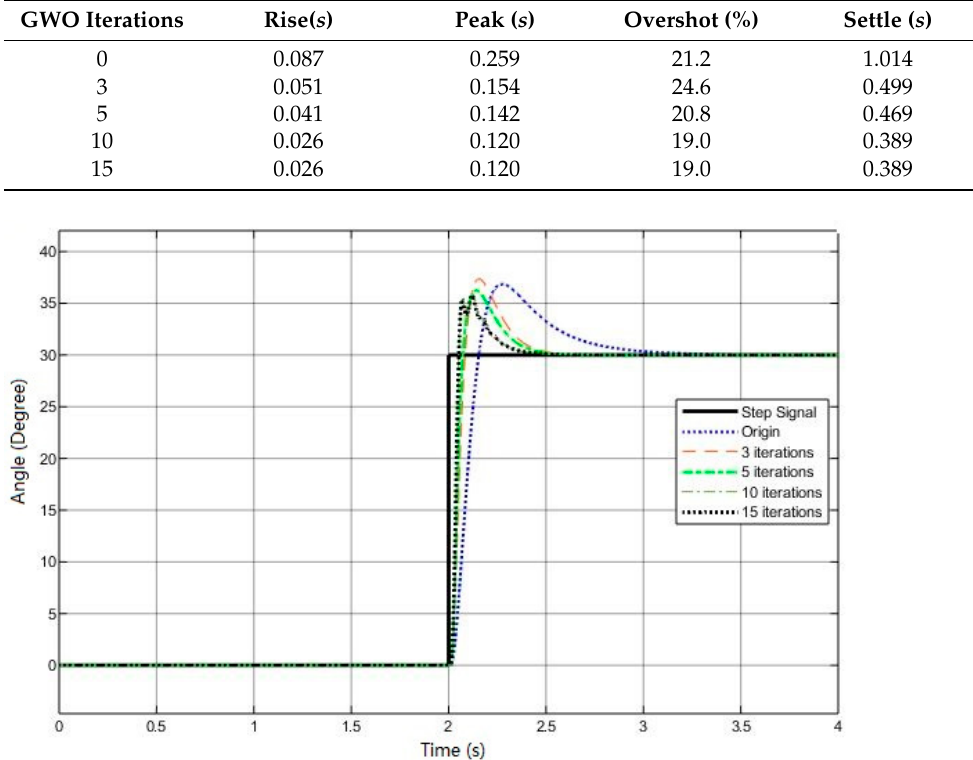
Table 3. Controller performance in terms of rise time, overshoot, and settling time.